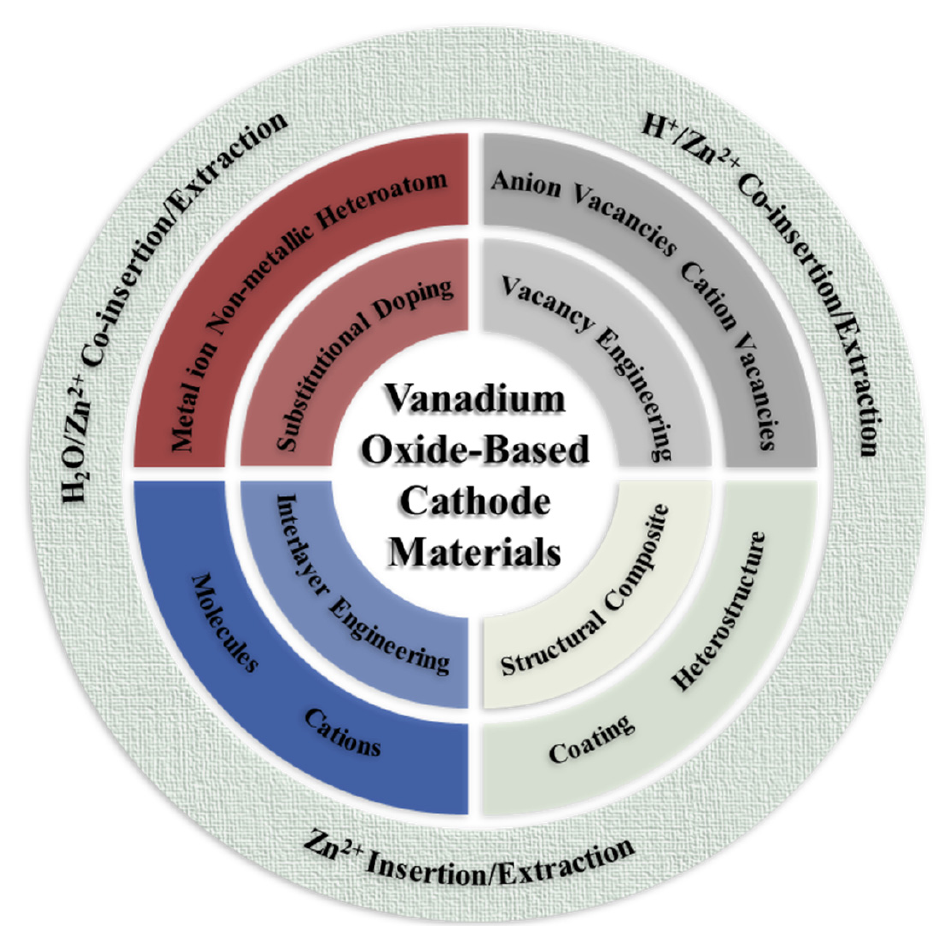
Figure 1. Overview of energy storage mechanisms and design strategy from vanadium oxide-based cathode materials for AZIBs.